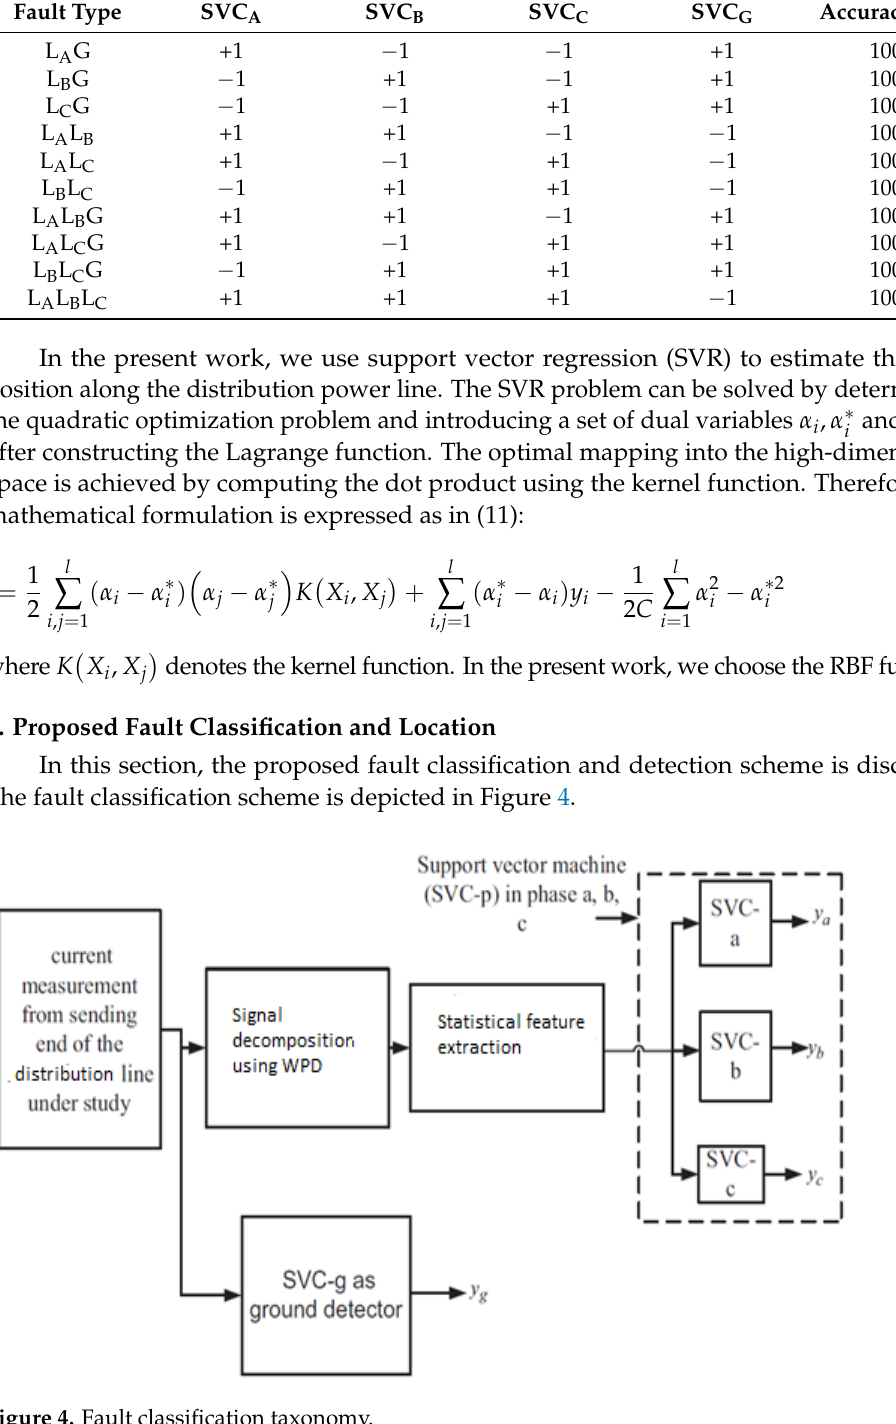
Table 1. SVC training matrix accuracy.